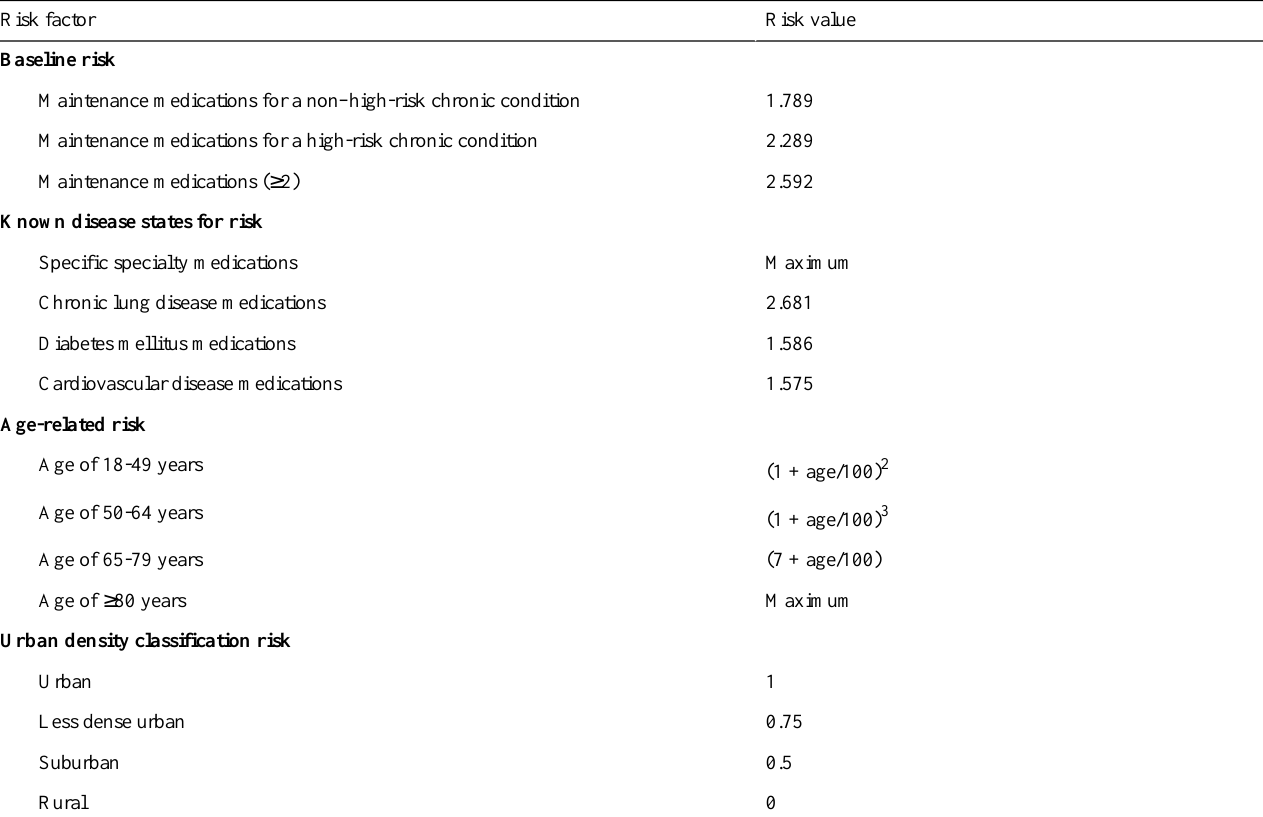
Table 1. Model inputs and